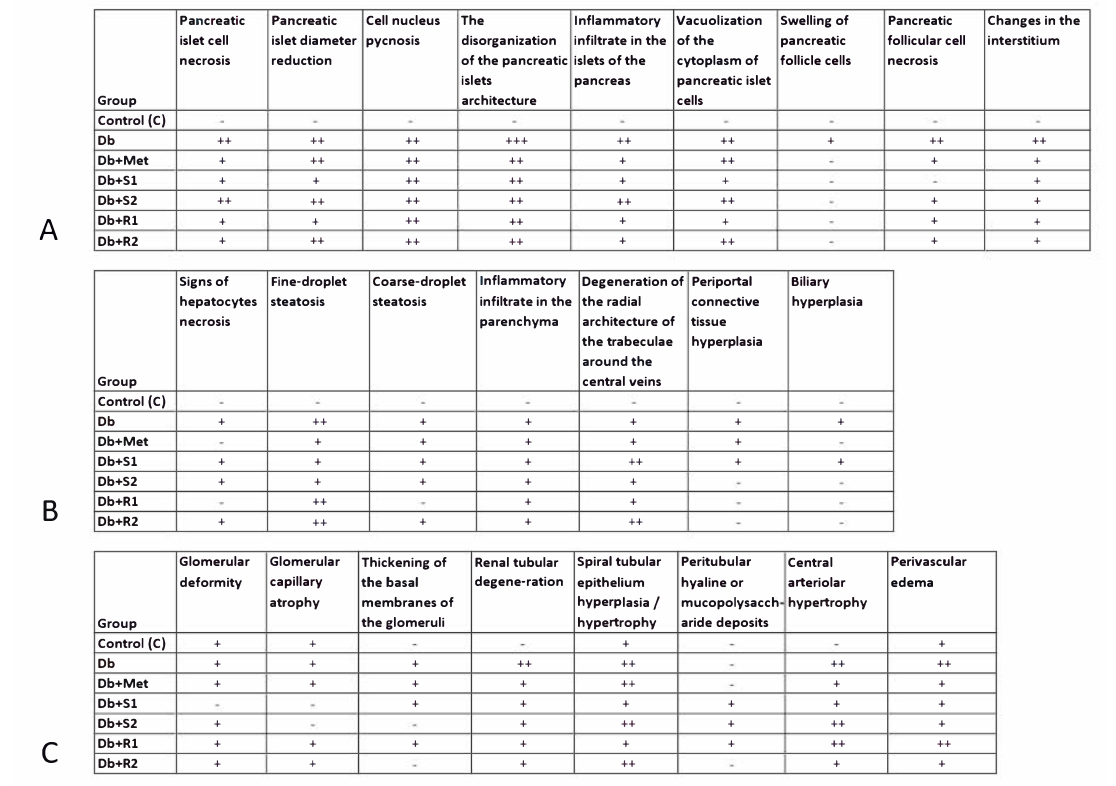
Figure 6. Effect of diet and supplementary SGs on histological alterations in organs of rats: ( A ) pancreas, ( B ) liver, and ( C ) kidneys. Symbols indicate the severity of the changes in each group. Visible pathological changes: no (-), mild (+), moderate (++), severe